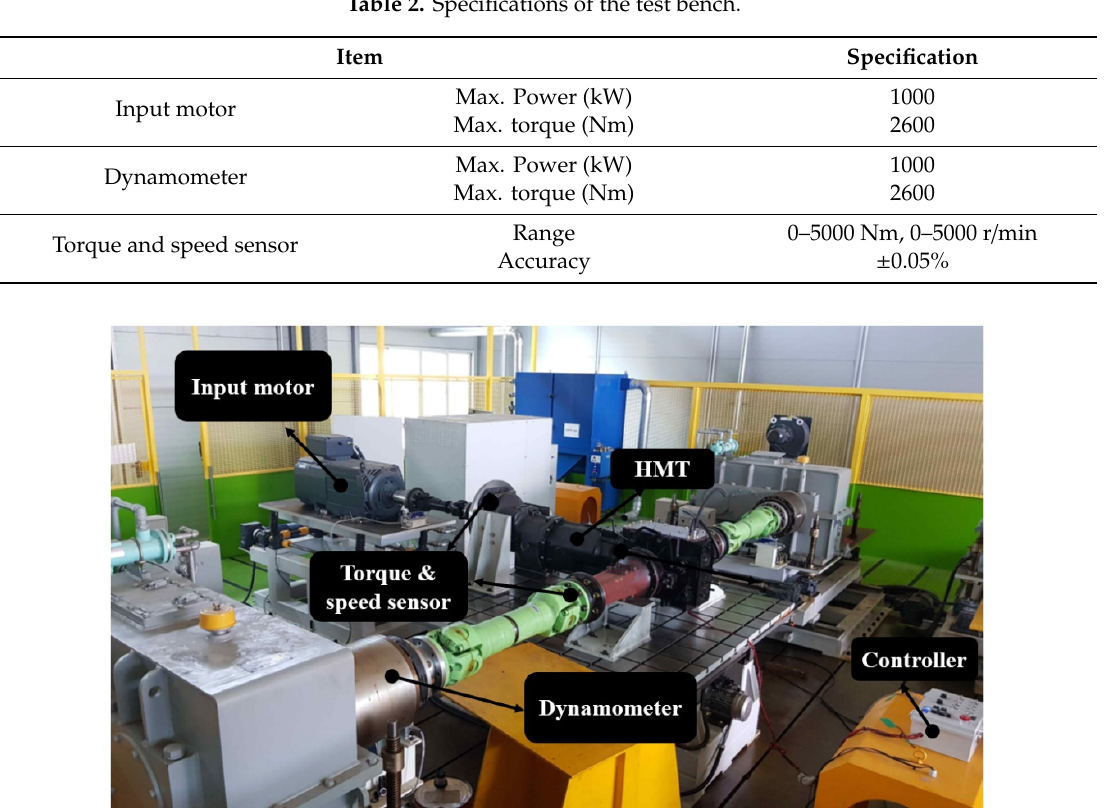
Figure 6. Photo of the test bench for the performance evaluation of the HMT used in this study.